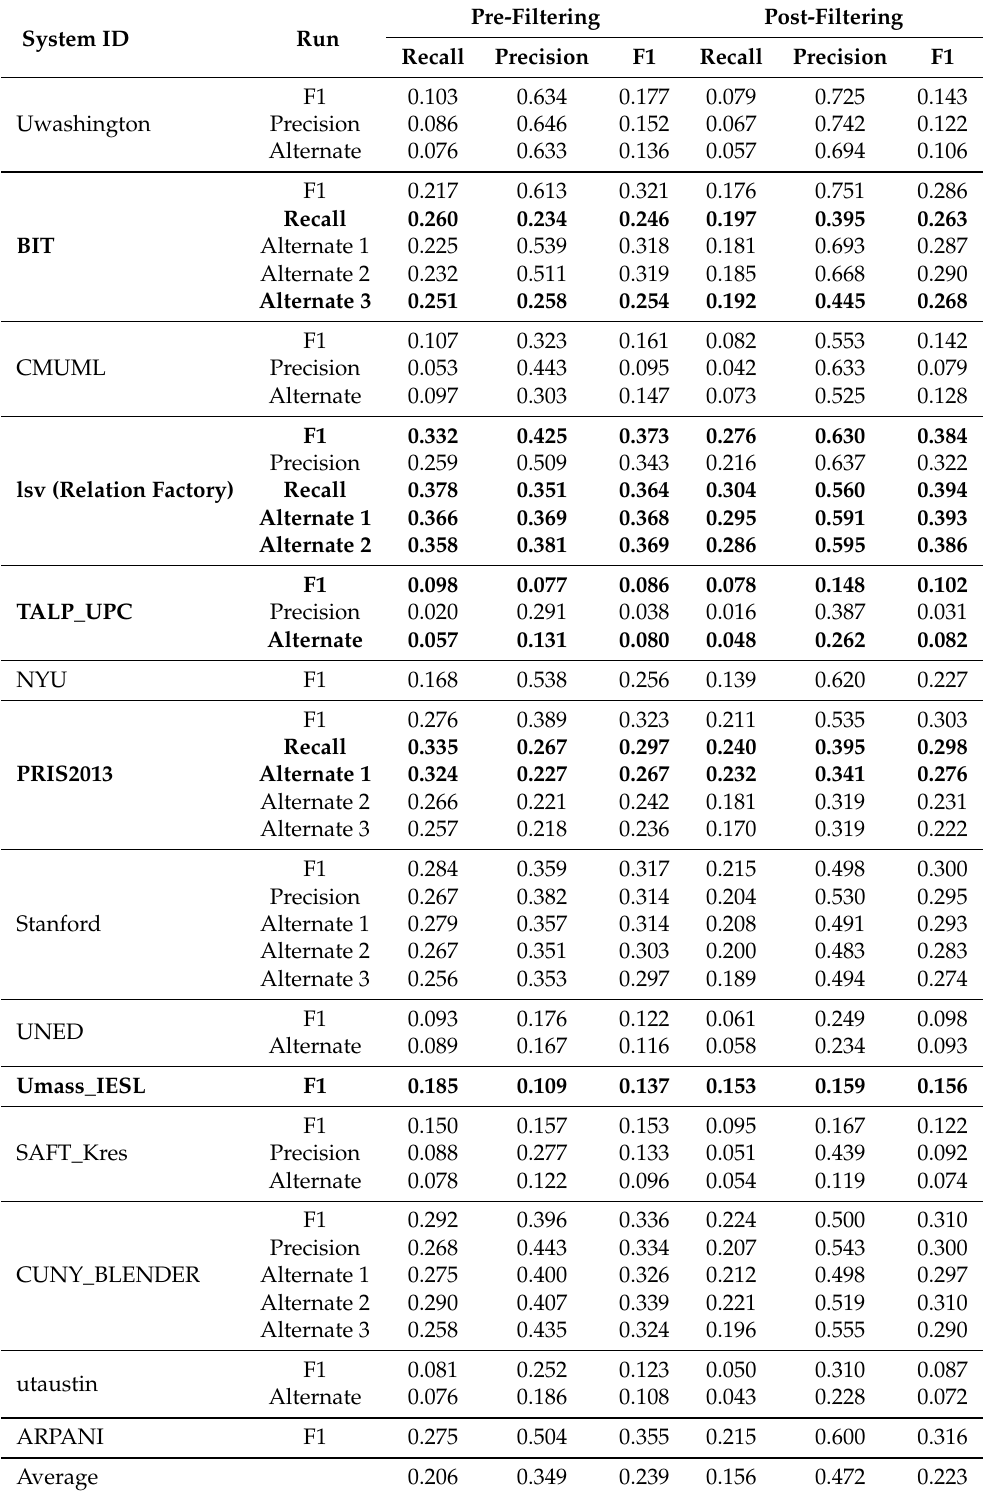
Table 9. Global evaluation for all systems using the TAC KBP 2013 Slot Filling scorer on the test dataset before and after filtering for all submitted